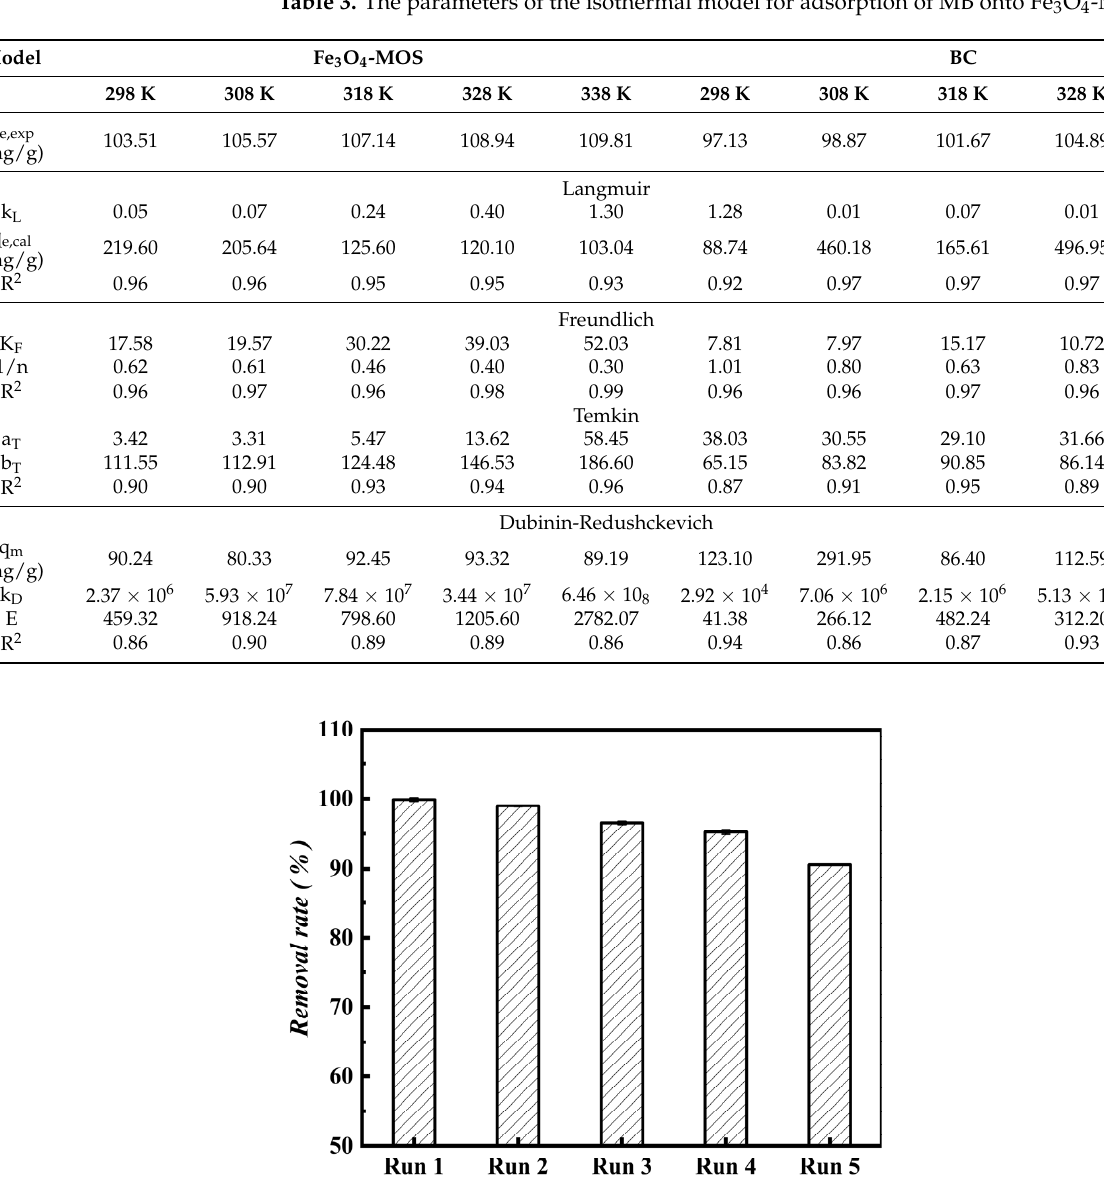
Table 4. Comparison of biosorption capacities of different biosorbents for MB dye elimination.